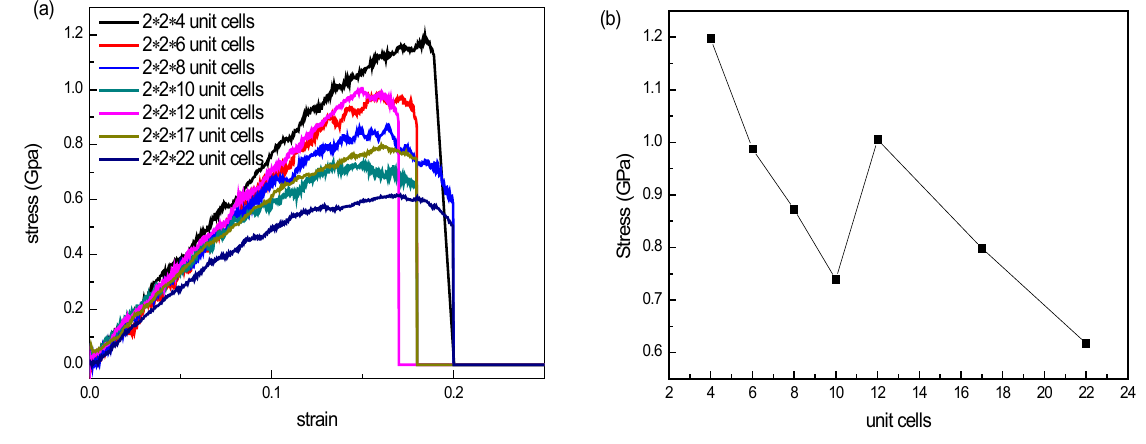
Figure 4 .: Strain–stress curves (a) in Z axis during stretching, and the maximum stress of different systems (b) in Z axis during